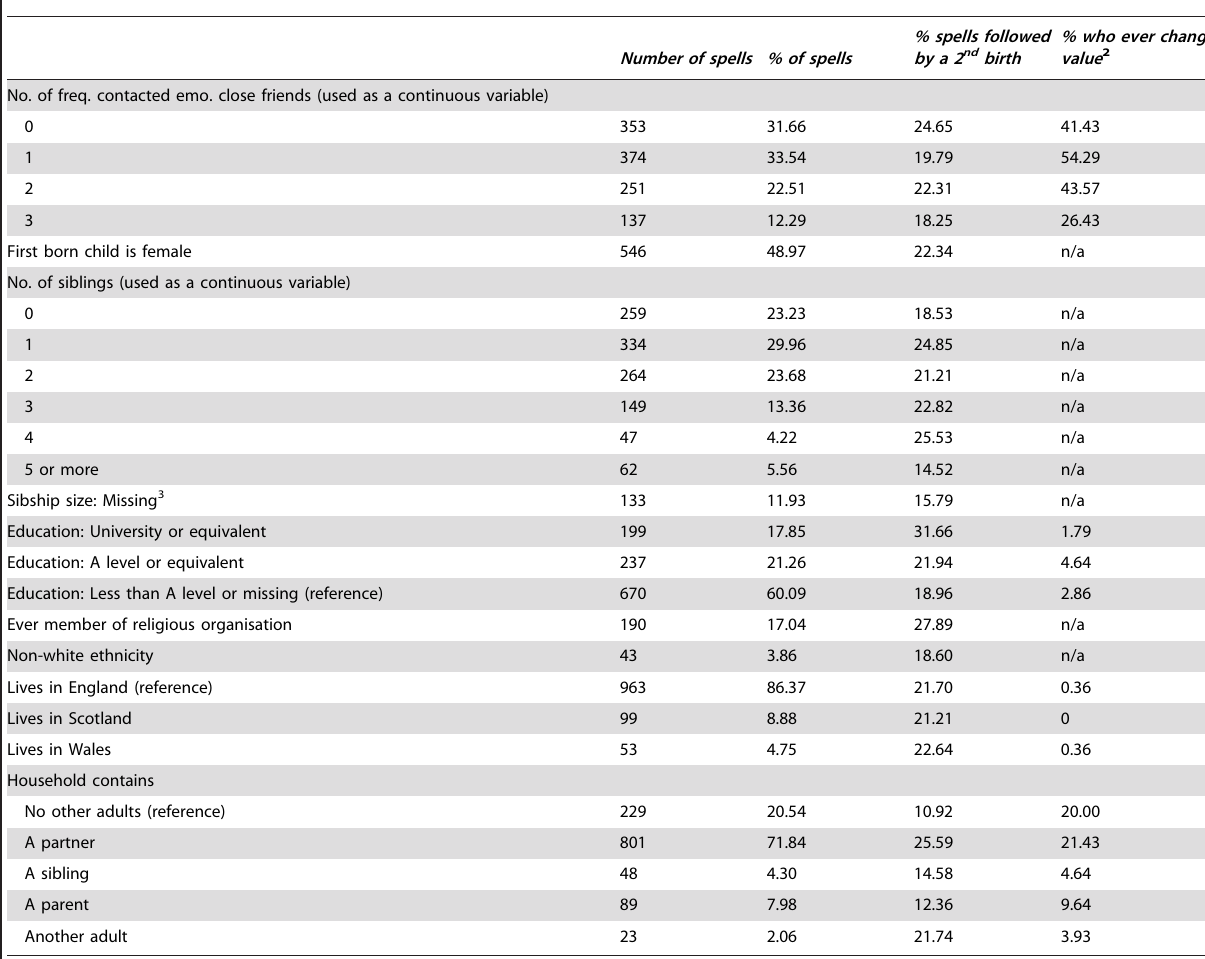
Table 2. Descriptive statistics of categorical control variables.